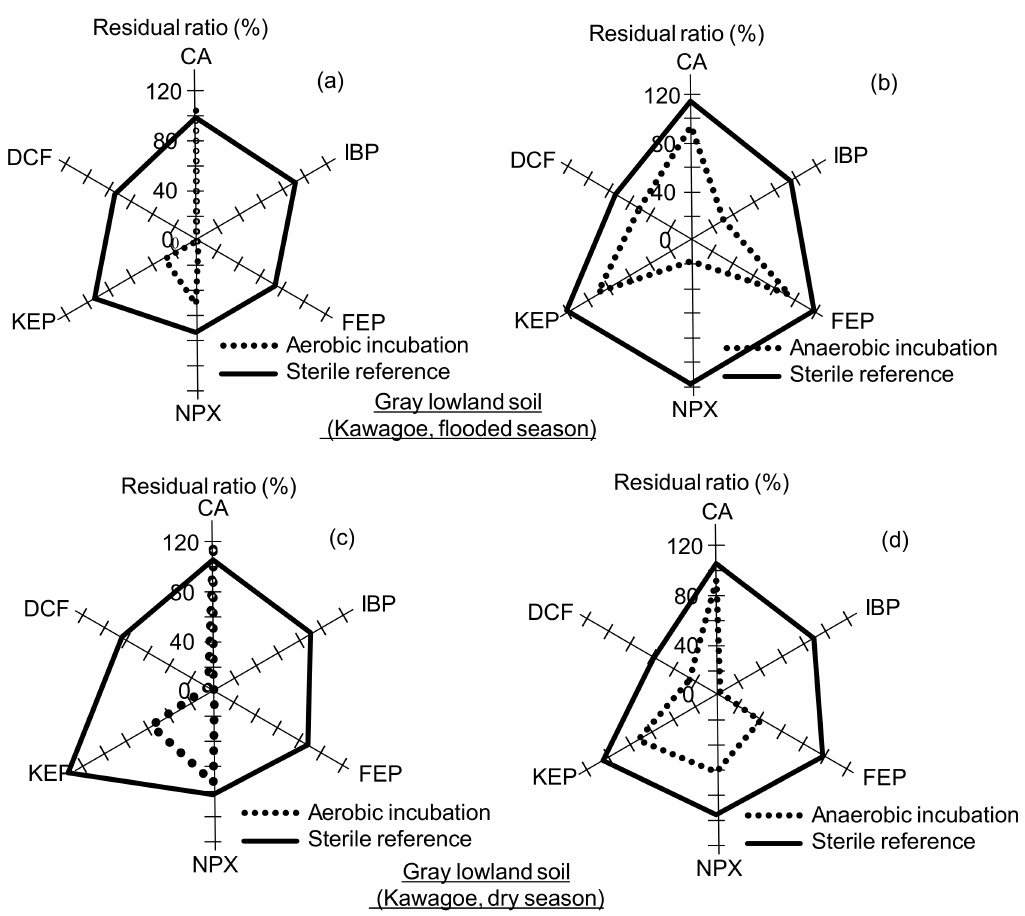
Figure 3. Residual ratios of the pharmaceuticals in gray lowland soil slurry (Kawagoe) taken at flooded season ( a , b ) and dry season ( c , d ) after 14 days of incubation under aerobic ( a , c ) and anaerobic ( b , d )